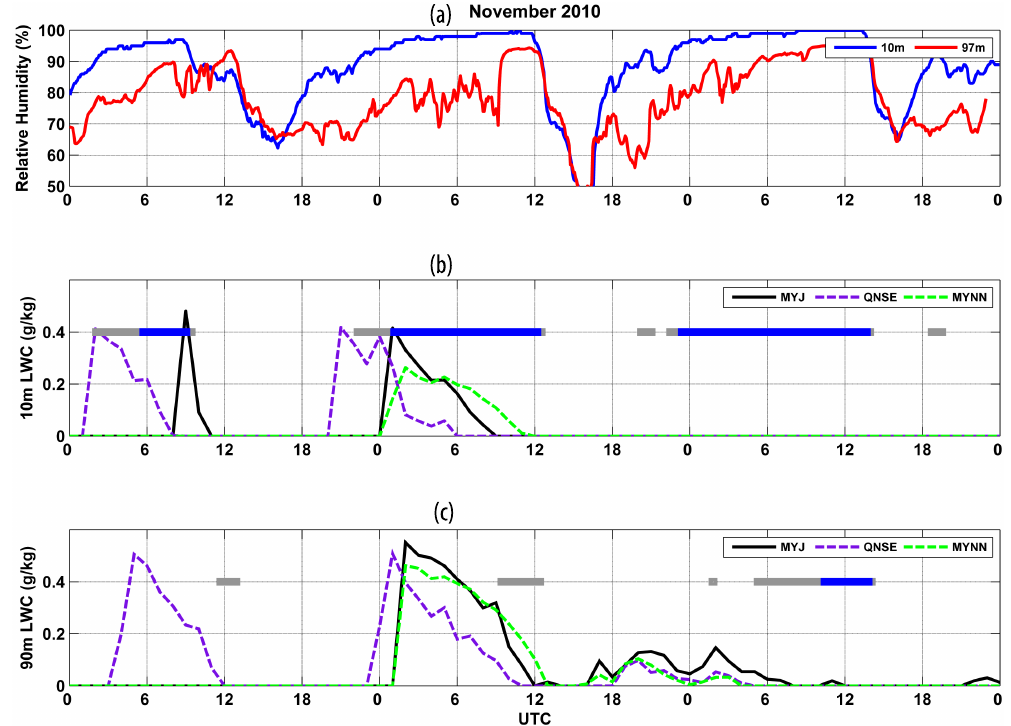
Figure 3. Analysis for 4, 5 and 6 November 2009. (a) Observed relative humidity at 10m (blue line) and 97m (red line). (b) Simulated LWC at 10m using MYJ (black line), QNSE (dashed purple line) and MYNN (dashed green line). Blue and grey rectangles indicate observed relative humidity at 10m larger than 95% and larger than 90%, respectively. (c) Same as (b) for 90m. Blue and grey rectangles indicate the same as in (b) but for